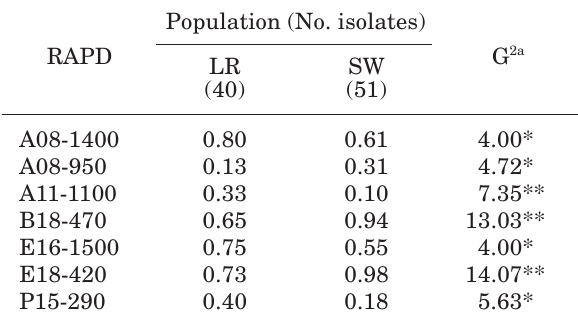
Table 5. Frequency of RAPD markers showing differ- ences (out of a total of 34 markers) and differentiation between Fomitiporia punctata populations from Langue- doc-Roussillon (LR) and South-West (CH and BX popu- lations were